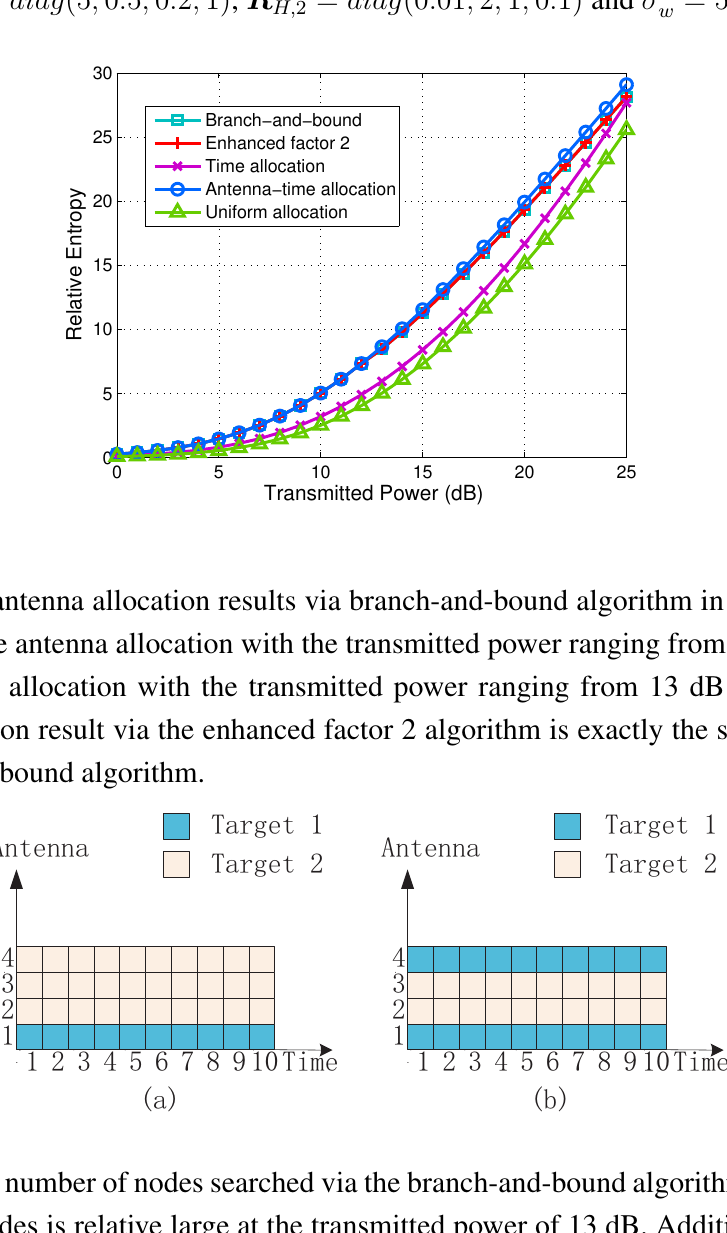
Figure 2. Minimum relative entropy of targets versus transmitted power via branch-and-bound algorithm, enhanced factor 2 algorithm, the time allocation scheme, the antenna-time allocation scheme and the uniform allocation scheme. M = 4 , N = 4 and = 5 . K = 2 . R = diag (5 , 0 . 5 , 0 . 2 , 1) , R = diag (0 . 01 , 2 , 1 , 0 . 1) and σ 2 H, 1 H, 2 w